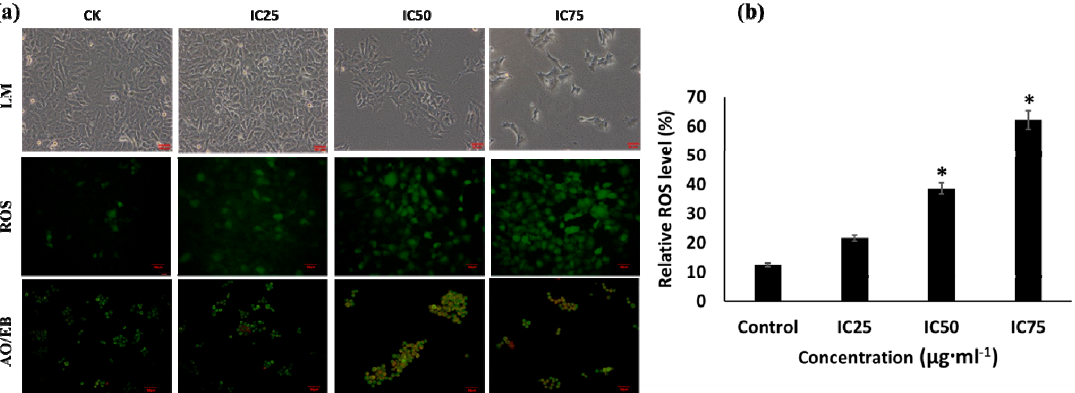
Figure 3. ( a ) Effect of the methanolic and water extracts of T. vernicifluum on cellular changes in A549 cells. ( b ) Relative reactive oxygen species level. IC—inhibitory concentration, LM—light microscopic images, ROS—reactive oxygen species, AO/EB—acridine orange and propidium iodide staining. Data are mean ± standard error (SEM, n = 3). The level of ROS is * p < 0.05 significantly varied with control treatment. The red scale bar in micrographs indicated the length of scale is 50 μ m.